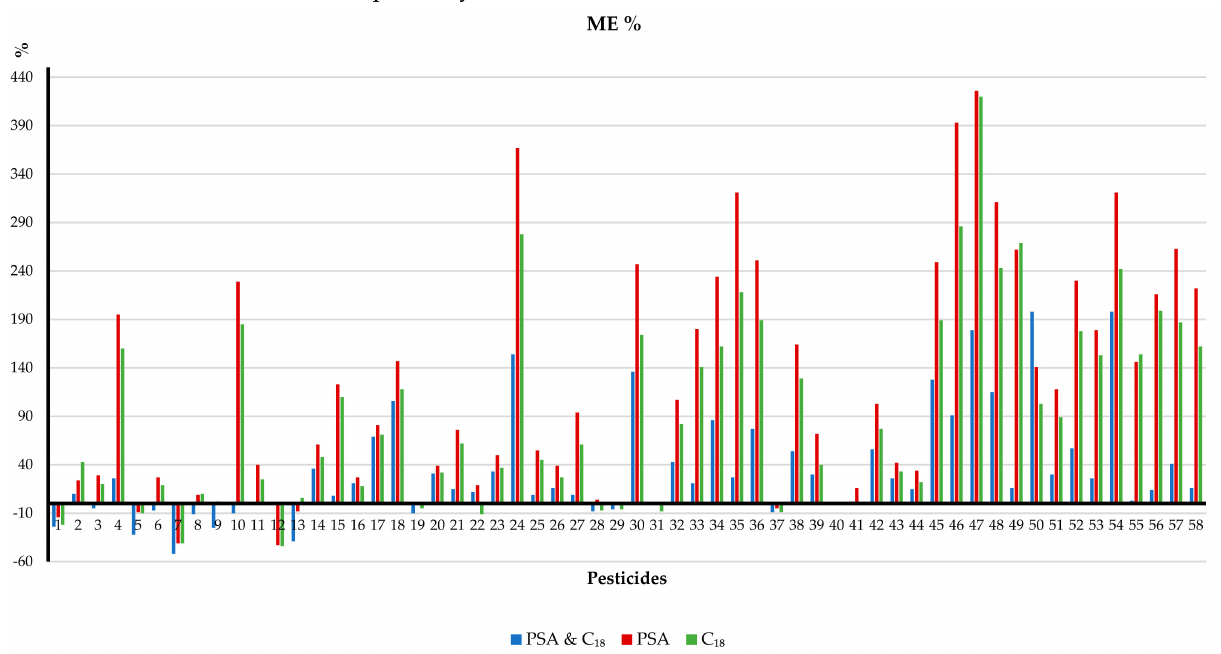
Figure 2. Matrix effects of the comparisons between different combinations of clean-up sorbents in soil samples. When matrix-effect (%) values are 0%, there is no matrix effect. Matrix-effect (%) values between 20% and 20% are mild. Matrix-effect (%) values between − 50% and − 20% or 20% and 50% are medium. Matrix-effect (%) values below 50% or above 50% are strong. Reprinted from [31], with permission from The Royal Society of